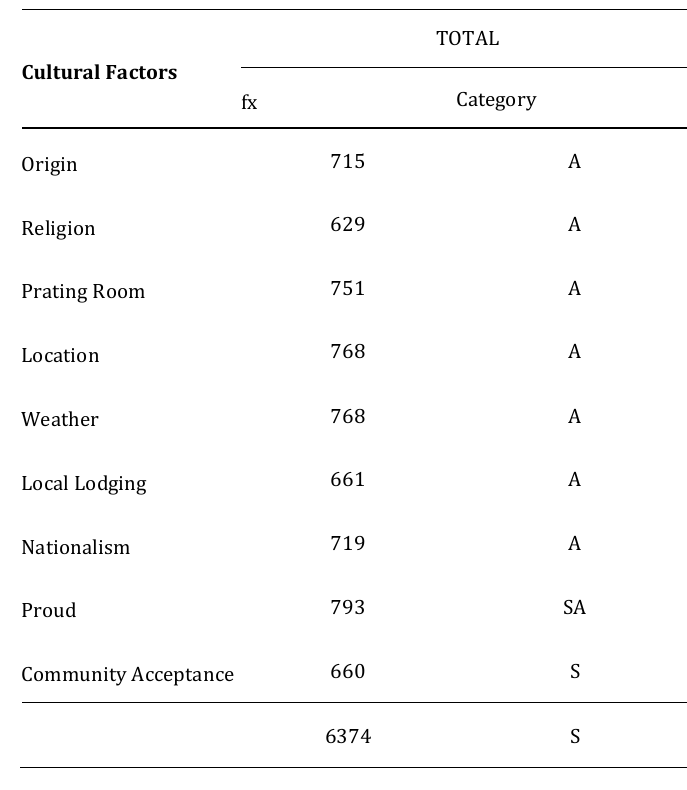
Table 1 Data analysis of cultural